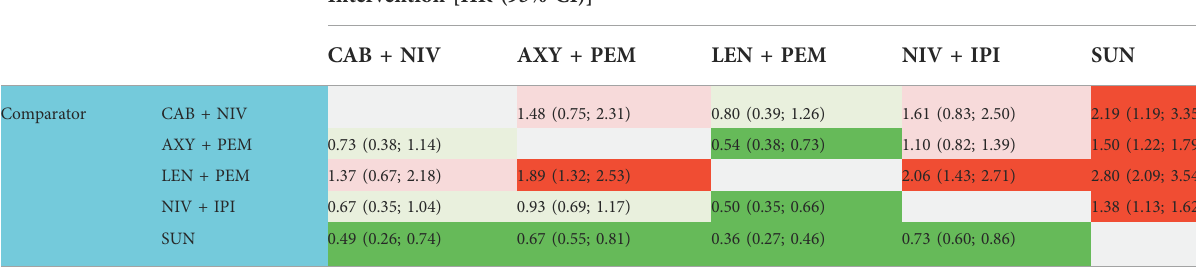
TABLE 7 Hazard ratios (HR) for progression-free survival in the population with an intermediate/poor